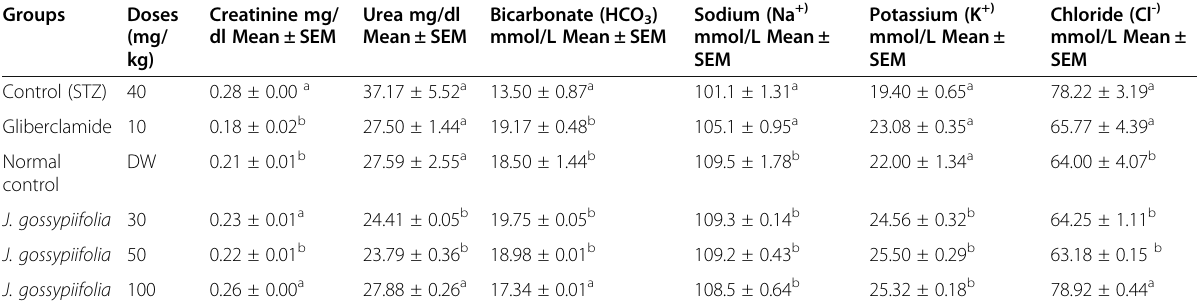
Table 5 Effect of Jatropha gossypiifolia L. on renal function test on day 14